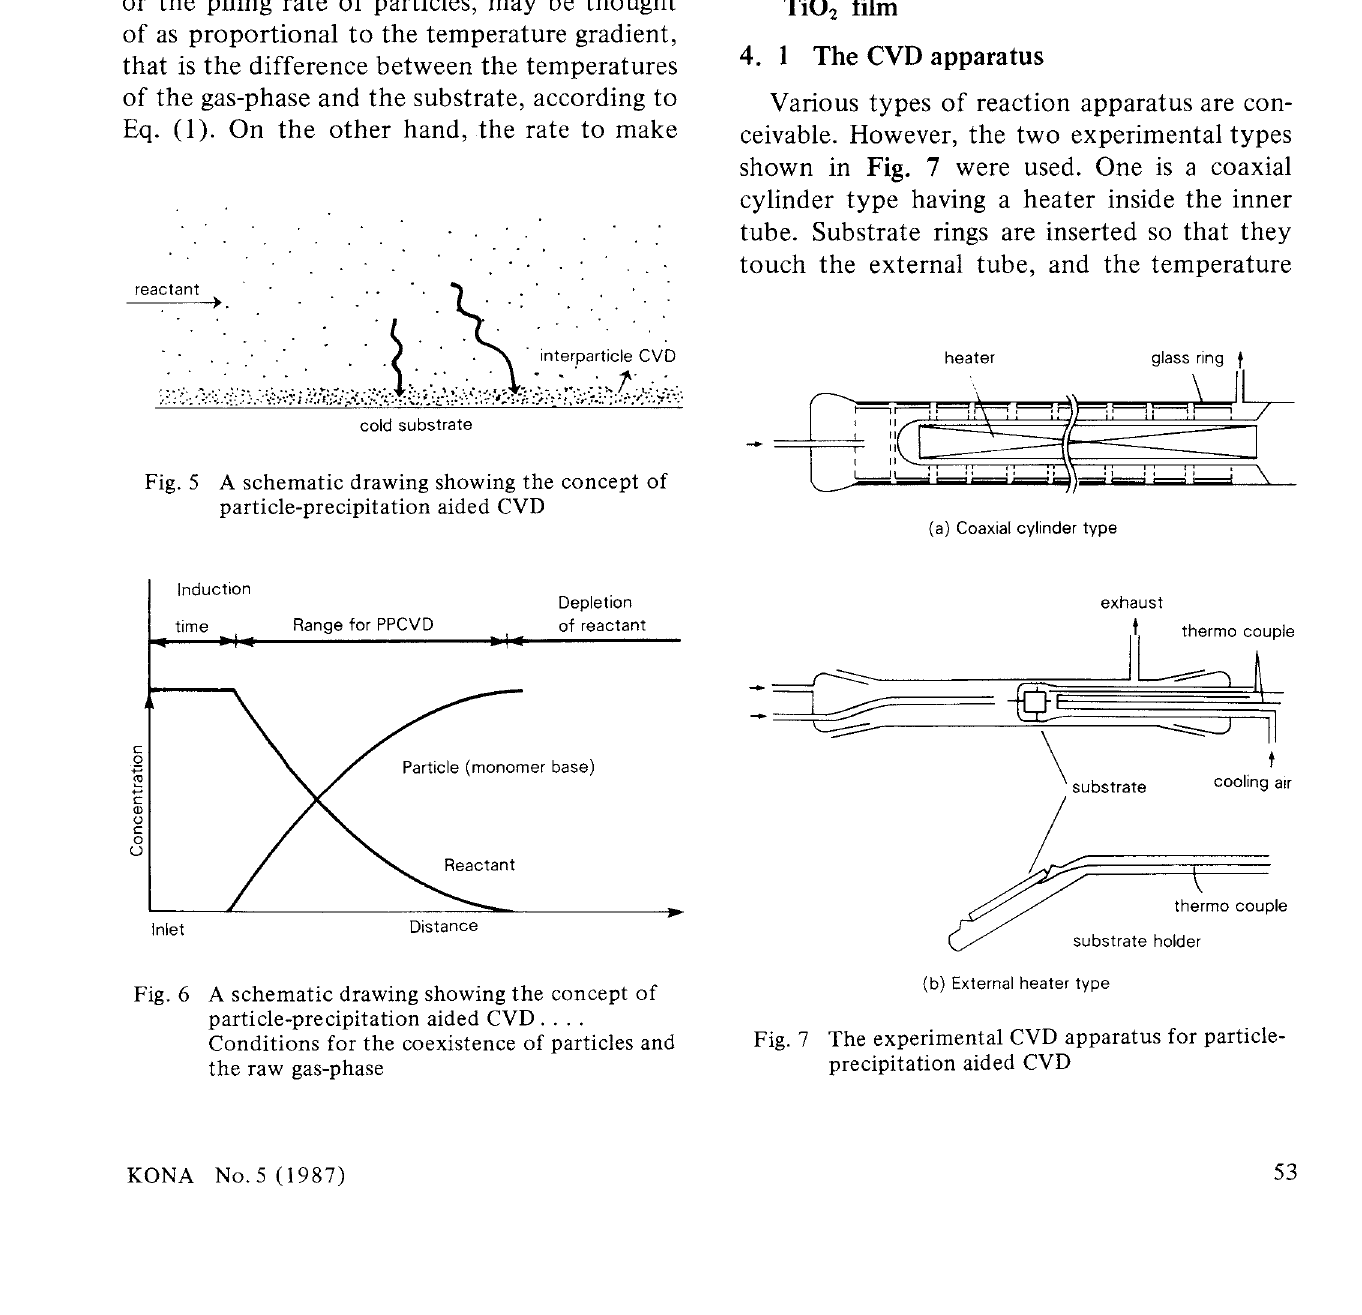
Fig. 6 A schematic drawing showing the concept of particle-precipitation aided CVD .... Conditions for the coexistence of particles and the raw gas-phase